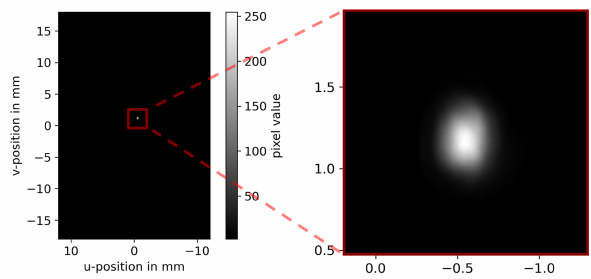
Figure 8. Image from the camera showing the spot at an arbitrary position of reflection on the camera